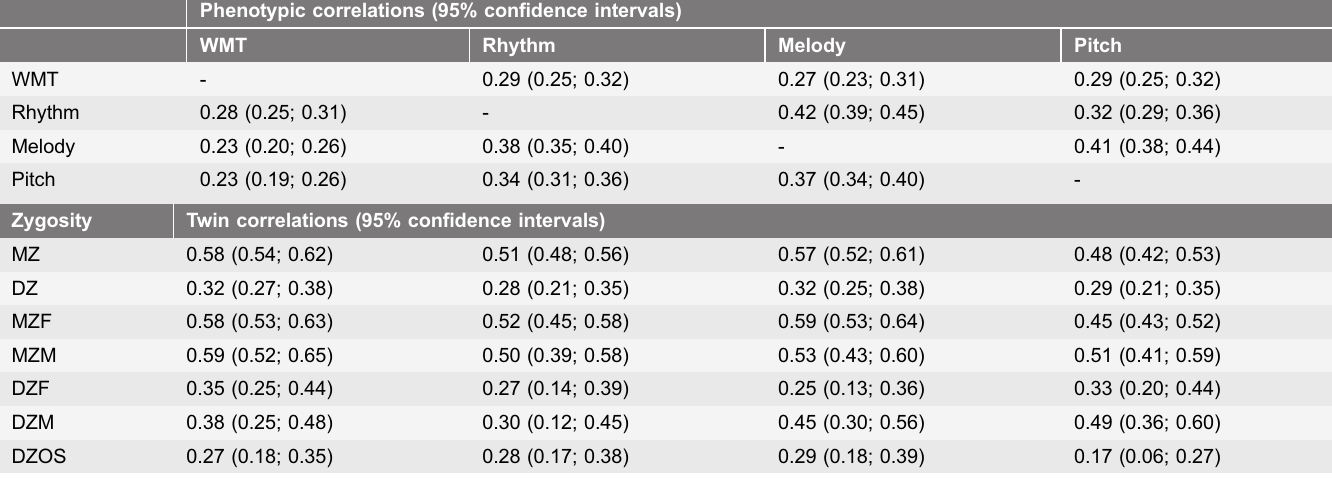
Genetic analyses Multivariate modelling results are shown in Table 3. All shared environmental (C) influences could be removed without a significant deterioration of model fit. Table 2. Phenotypic correlations (top) for females (below diagonal) and males (above diagonal) and twin correlations for each zygosity (bottom) for WMT, Rhythm, Pitch, and Melody corrected for sex and age. Phenotypic correlations (95% confidence